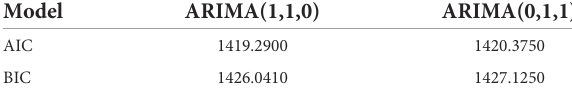
TABLE 3 Comparison of AIC and BIC values ARIMA( p , d , q ) model.